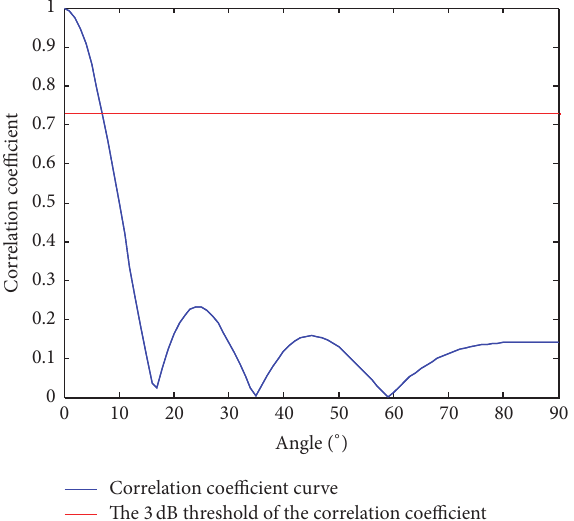
Figure 3: Correlation coefficient between various-angle steering vector and 0 degree steering